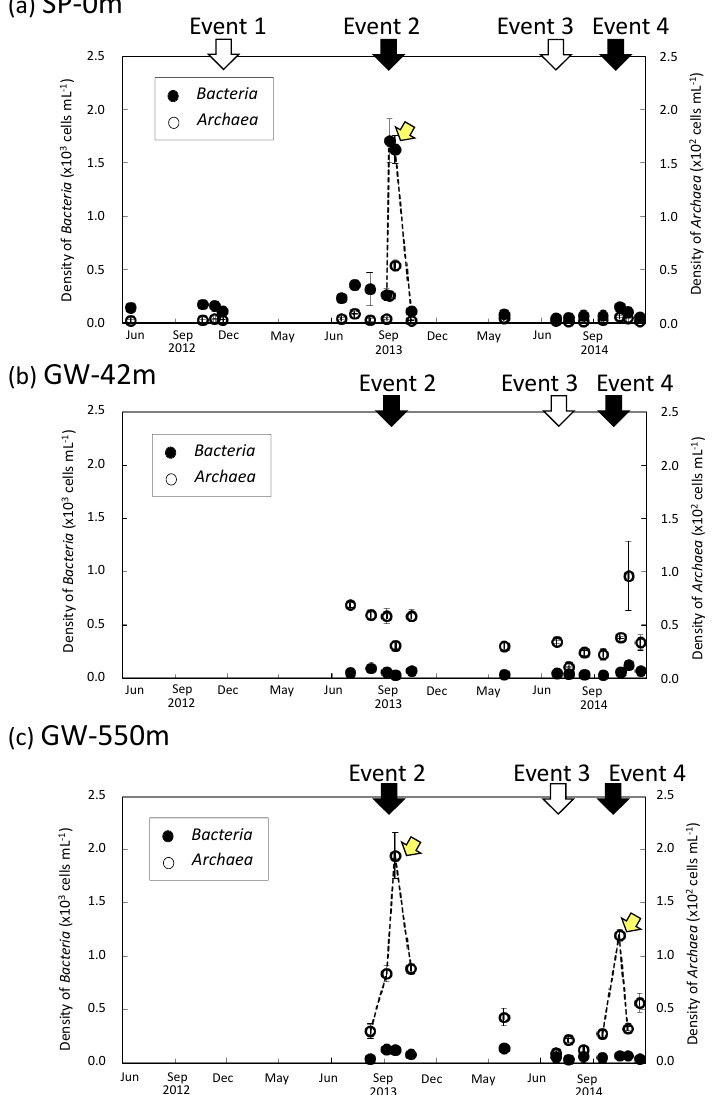
Figure 3. Changes in community structure of prokaryotes in groundwater. (a) Groundwater at SP-0m, (b) shallow groundwater at GW-42m, and (c) deep groundwater at GW-550m. Black and open arrows indicate the rainfall event: Event 1, Event 2, Event 3, and Event 4. Black arrows indicate the torrential rainfall. Yellow arrows indicate the signature of impact of